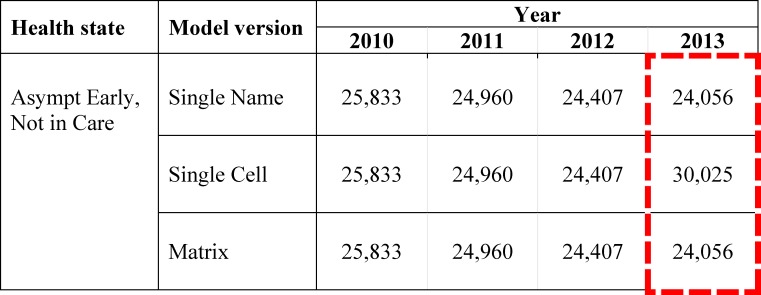
Example of unintentional errors detected by comparing model projections.This figure is a snapshot of projections from all three model versions (Single Name, Single Cell, Matrix) for the Guideline-based ART revision. Each cell in this snapshot shows the number of people living with HIV projected to be in a given health state (Asymptomatic Early stage of disease, Not engaged in care) between 2010 and 2013, after standard debugging. The figure shows that model output for this health state is identical across the three model versions for 2010, 2011, and 2012, indicating no unintentional implementation errors. However, in 2013, the projected output for this health state differs across the three model versions (Single Name: 24,056, Single Cell: 30,025, Matrix: 24,056). In this example of an unintentional error, the principle error was due to an incorrect cell reference in the Single Cell model version, was propagated over an additional 10 health states, and took 10 minutes to identify and correct. Full model projections for the Guideline-based ART revision with unintentional errors are available in tabs Model (SN), Model (SC), and Model (Matrix) in S5 File.